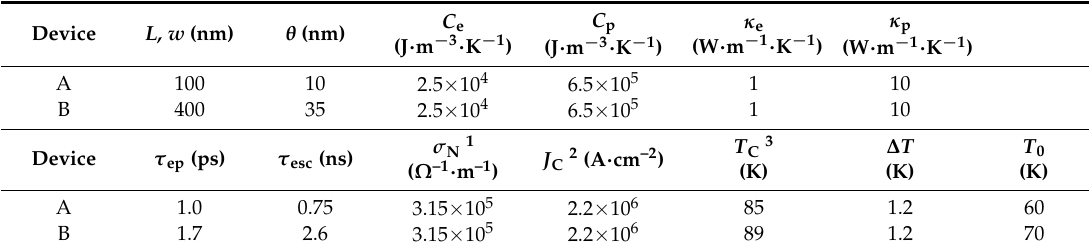
Table 1. For constrictions A and B, device characteristics and YBCO physical parameters used in the simulations. Unless otherwise stated, the parameter values are those of [22].